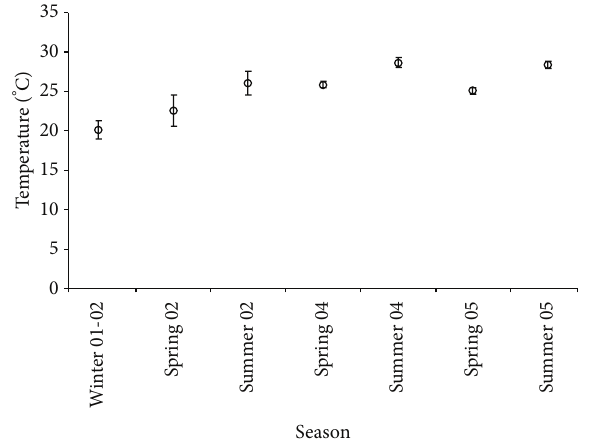
Figure2:Meantemperaturevalues( ∘ C)duringthesampledseasons and